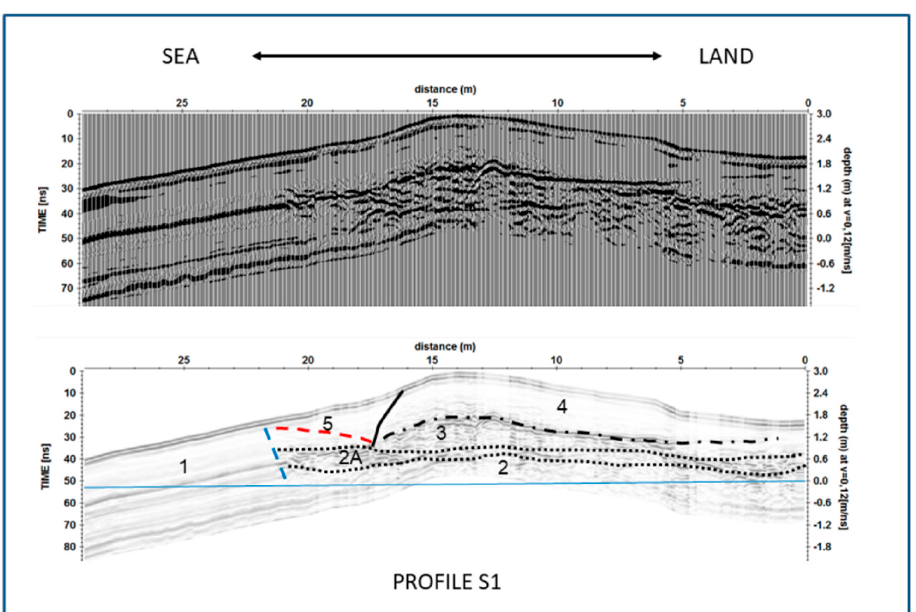
Figure 10. The GPR section (upper) performed at Profile S1 (La Strea site) and its interpretation (lower). The section is shown in wiggle traces. Legend: 1—saturated zone; 2—bedrock (Mesozoic limestone); 2A—bedrock (Pleistocene calcarenites); 3—soil; 4—sand ridge deposits; 5—storm wave berm. The blue dashed line divides the saturated from the unsaturated zone, while the red dashed one outlines the landward-sloping lamination of a storm wave berm. The blue horizontal line is the position of mean sea level.